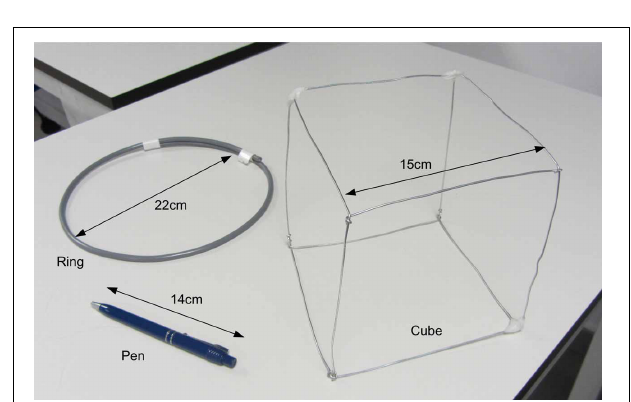
FIGURE 12 | Photograph of the three objects used to test the 3D reconstruction algorithm: a pen, a ring, and a